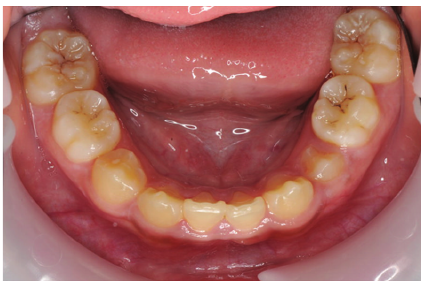
Figure 4: Dental pantomogram confirming congenitally absence of lower lateral incisors and upper midline